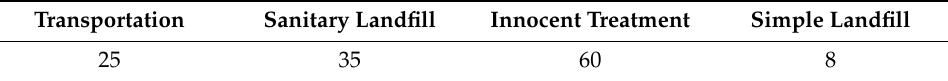
Table 6. Unit virtual abatement cost of household